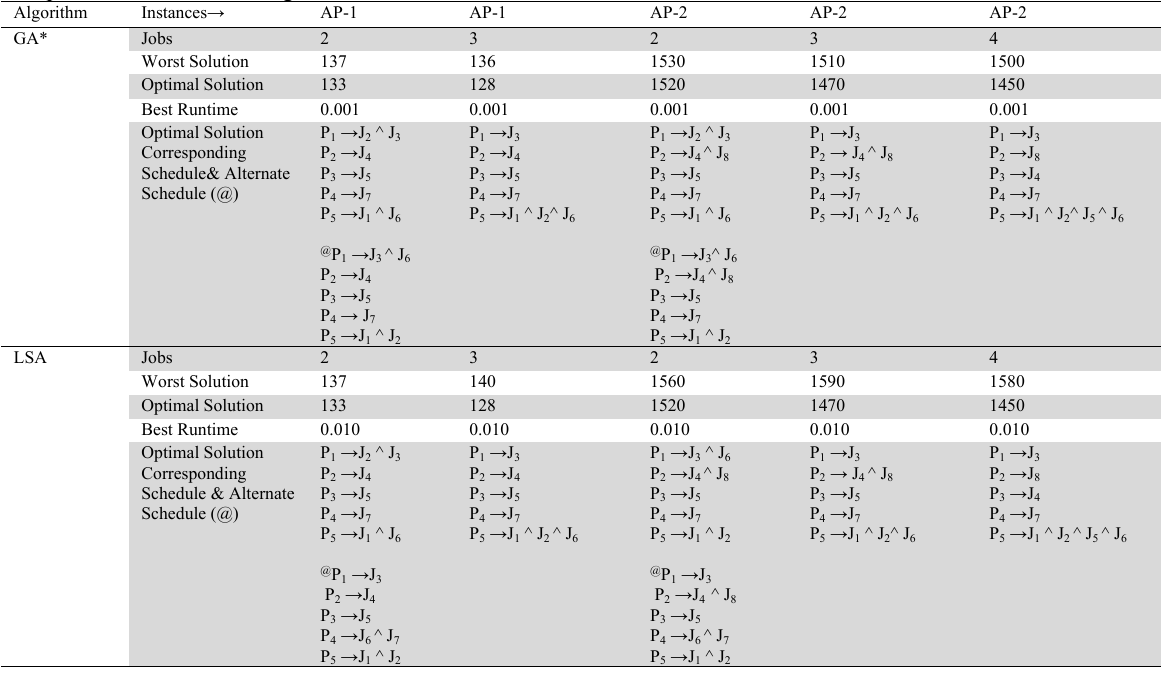
Comparative results of LSA against GA* for AP-1 and AP-2 Algorithm Instances →